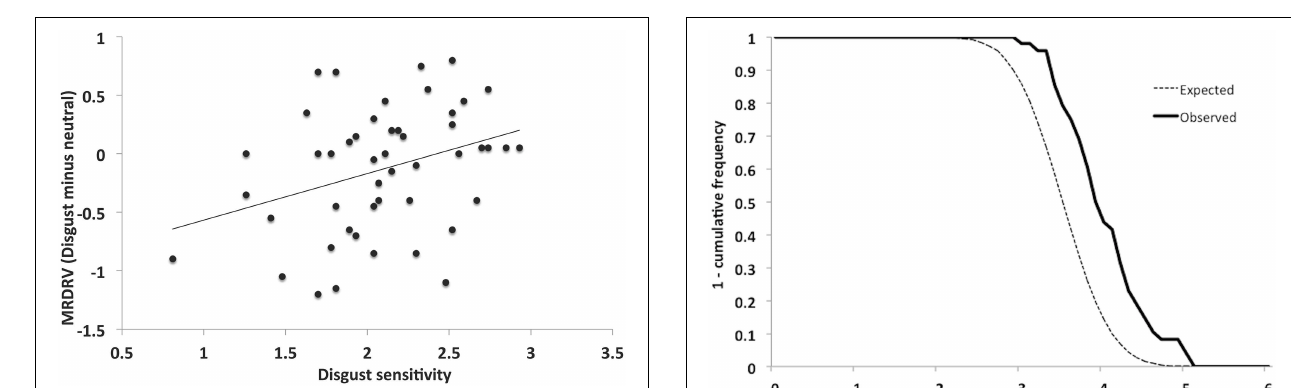
FIGURE 4 | Bi-directional relationship between disgust sensitivity and modulation of dishonesty. The difference in the mean reported dice roll values between blocks was significantly positively correlated with disgust sensitivity, indicating replication of the bi-directional function of individual sensitivity determining the sign and size of moral modulation due to disgust stimuli.